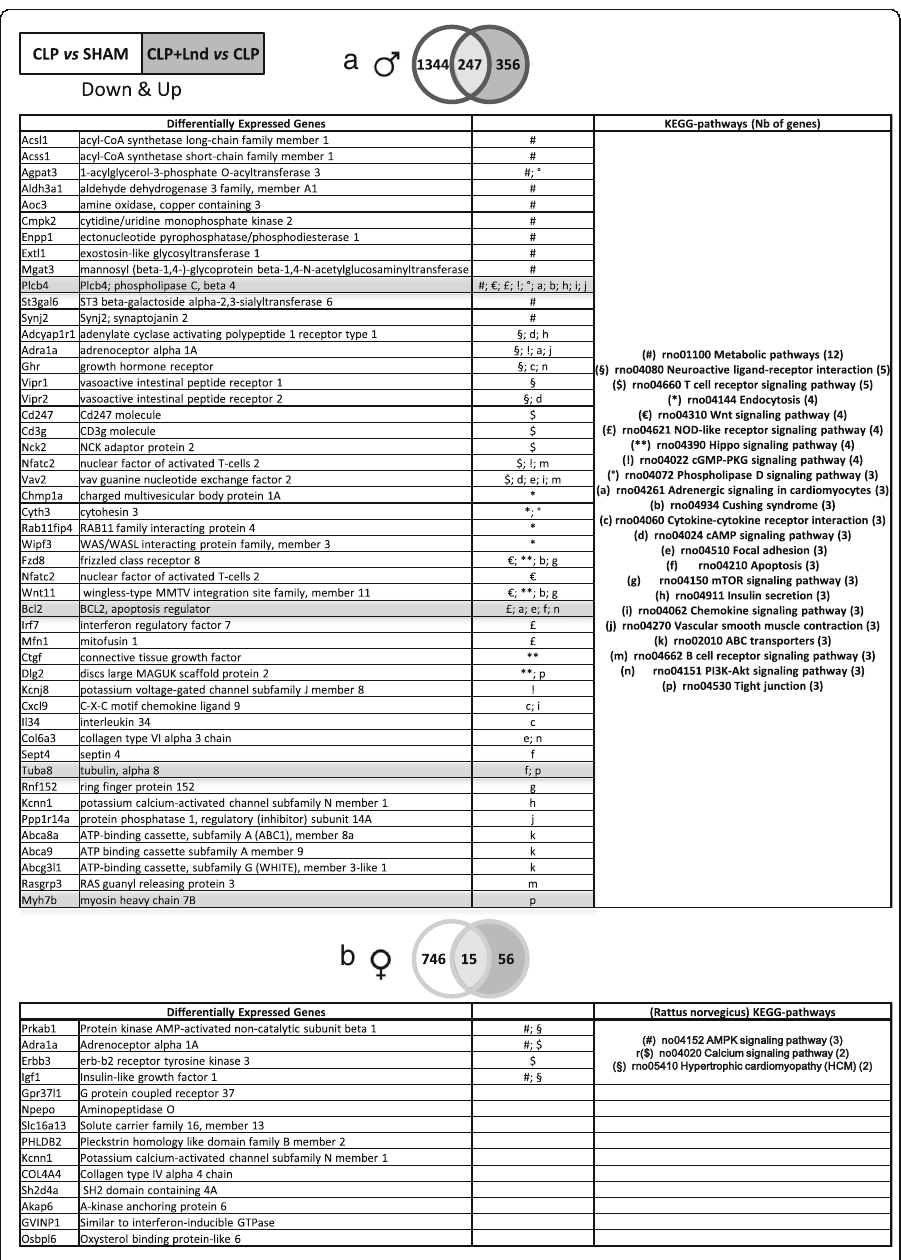
Fig. 3 KEGG-pathways associated with down-regulated genes after cecal ligation and puncture and back- regulated by landiolol infusion. a Venn diagram associated with the 1591 down-regulated genes in CLP group and the 603 up-regulated genes in CLP plus landiolol group in males. The 247 common genes represent regulated genes with a characteristic V form, down-regulated in sepsis and back-regulated by landiolol infusion. No significant biological processes were found associated to these 247 common genes. The table presents KEGG-pathways in which at least three of these 247 common genes are involved. Genes associated with the JAK/STAT pathway, BCL2 and AOX, and with the adrenergic pathway, PLCB4, TUBA8 and MYH7B, are highlighted in grey. b Venn diagram associated with the 761 down-regulated genes in CLP group and the 71 up-regulated genes in CLP plus landiolol group in females. Note that only 71 genes were up-regulated in the CLP plus landiolol group and that only 15 of them were back-regulated. No biological processes were found associated to these 15 common genes presented in the table; four genes are members of specific KEGG- pathways and the others are isolated genes. CLP cecal ligation and puncture, CLP + Lnd CLP plus